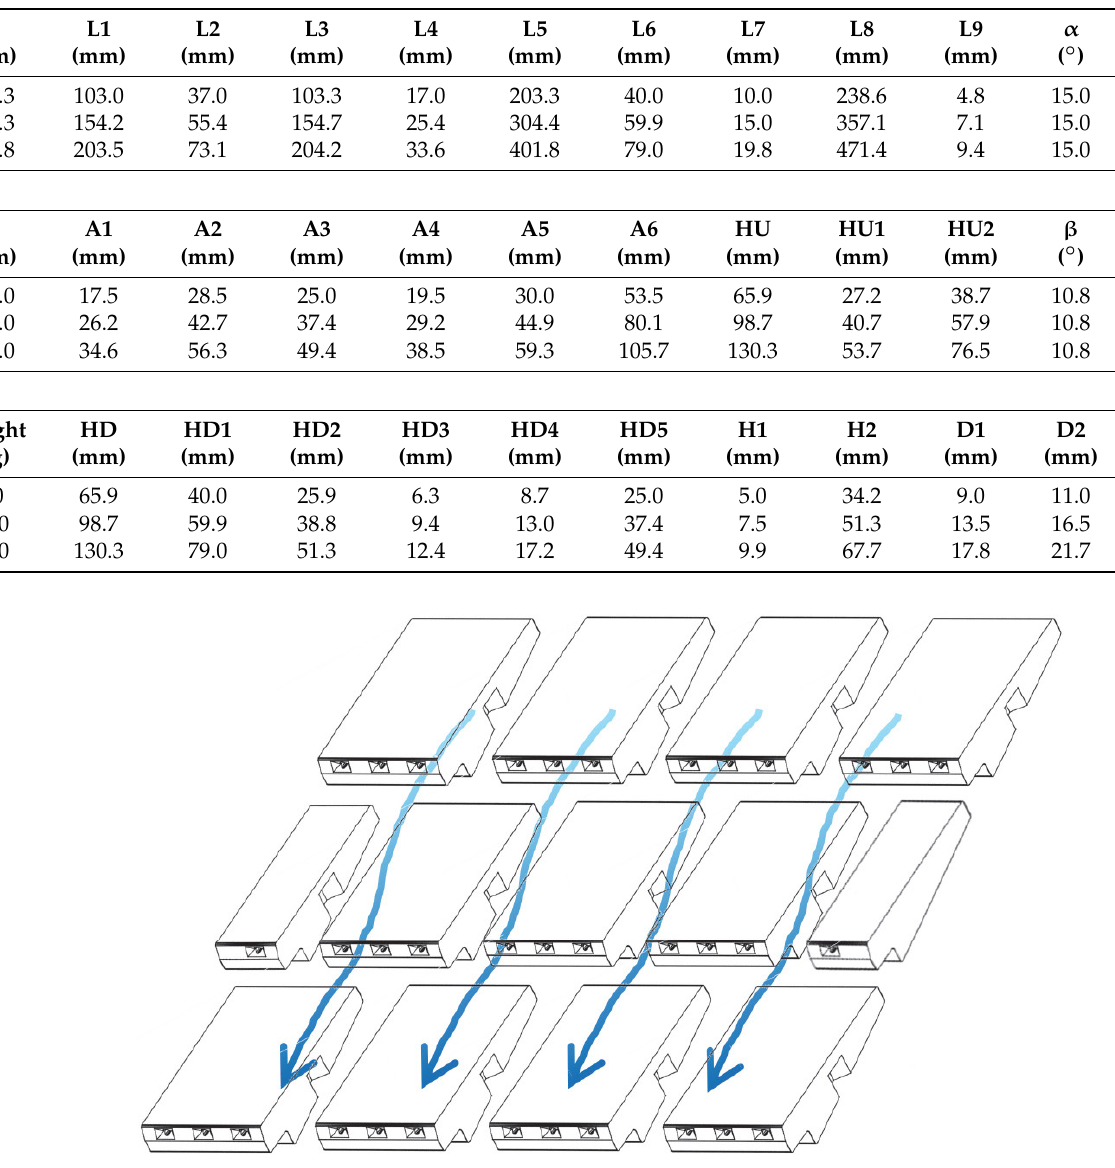
Figure 8. Scheme of the placement of WSB in rows and the creation of staggered longitudinal joints by using half-WSB. The arrows represent the flow of water .